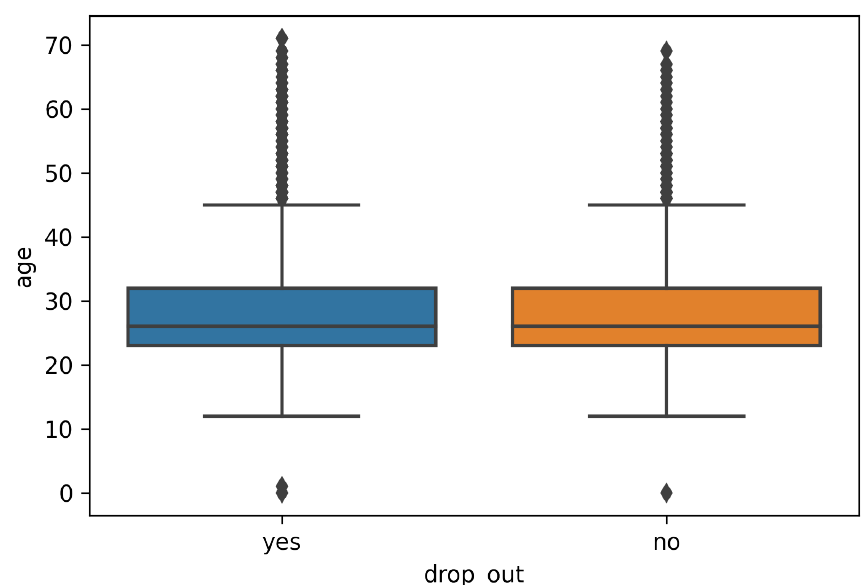
Figure 4. Box plot of dropout and age statistics.